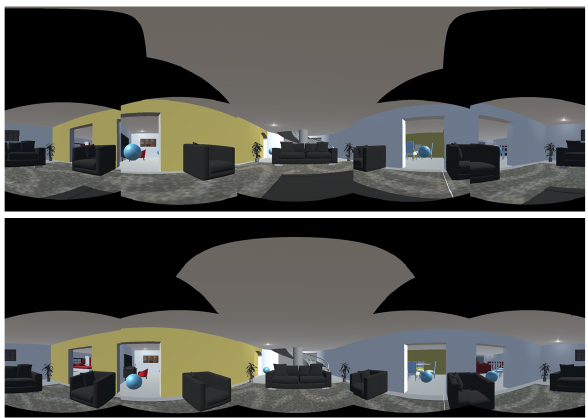
Figure 8. Panorama from camera rig with stereo base length of 40 cm and projected sphere radius of 4 m (top) and 20 cm and projected sphere radius of 20 m (bottom)